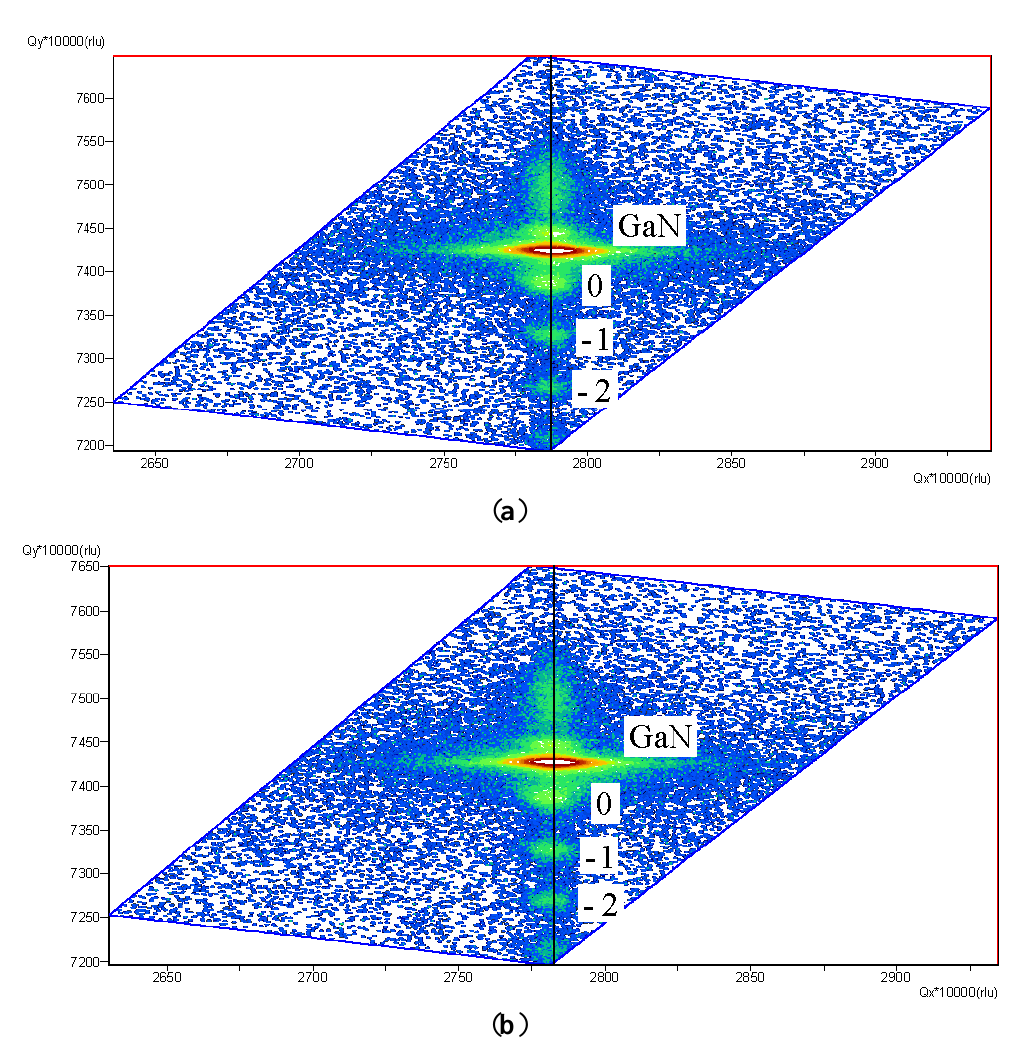
Figure 2. Reciprocal space mapping around the asymmetric reflection